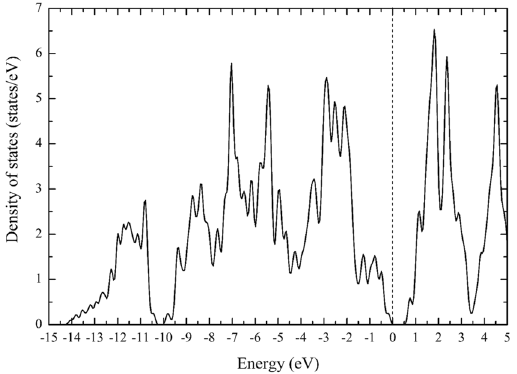
Figure 5. ReCN bulk density of states showing the semiconductor character. The reference energy was set at the energy of the last occupied state.